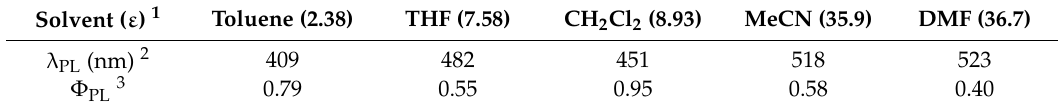
Figure 6. ( a ) PL spectra of 1bC in various solvents (concentration: 1.0 × 10 − 6 mol L − 1 ); ( b ) photographs under UV irradiation ( λ ex = 365 nm) and CIE chromaticity diagram for the PL in various solvents. Table 2. Photophysical properties of 1bC in various solvents.